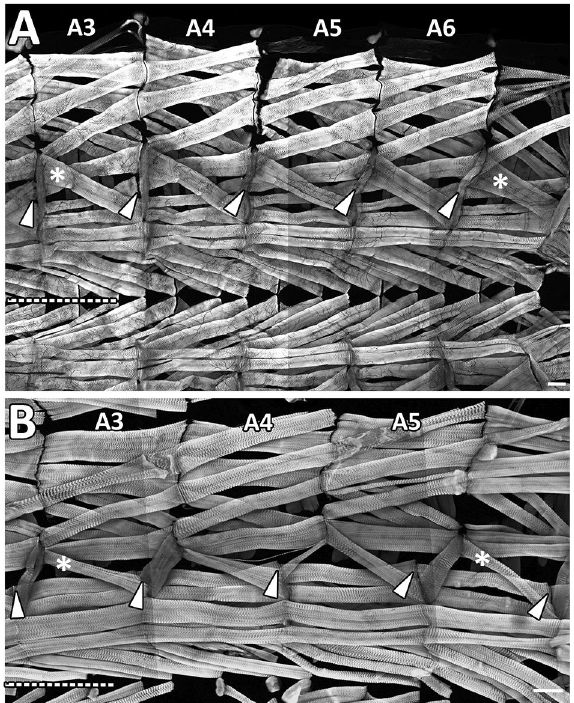
Figure 6. Comparison of the stereotyped muscle pattern in abdominal segments of Ceratitis and Drosophila larvae. ( A ) Tile scan of a dissected C. capitata larva showing phalloidin stained muscles fibres in abdominal segments A3–A6. M5 (asterisks) is particularly thick in all segments. Arrowheads indicate that M12 joins the attachment site of M4 in the next posterior segment. Dashed line labels the ventral midline. ( B ) Tile scan of a dissected Drosophila larva showing muscles in abdominal segments A3–A6. Arrowheads indicate that M12 joins the attachment site of M12 in the next posterior segment. M5 (asterisks) is relatively thin, but ventral longitudinal muscles (M12, M13, M6, M7) are comparatively strong, which is probably advantageous for crawling on horizontal substrates. Dorsal is up and anterior left. Note different scales. Scale bars 100